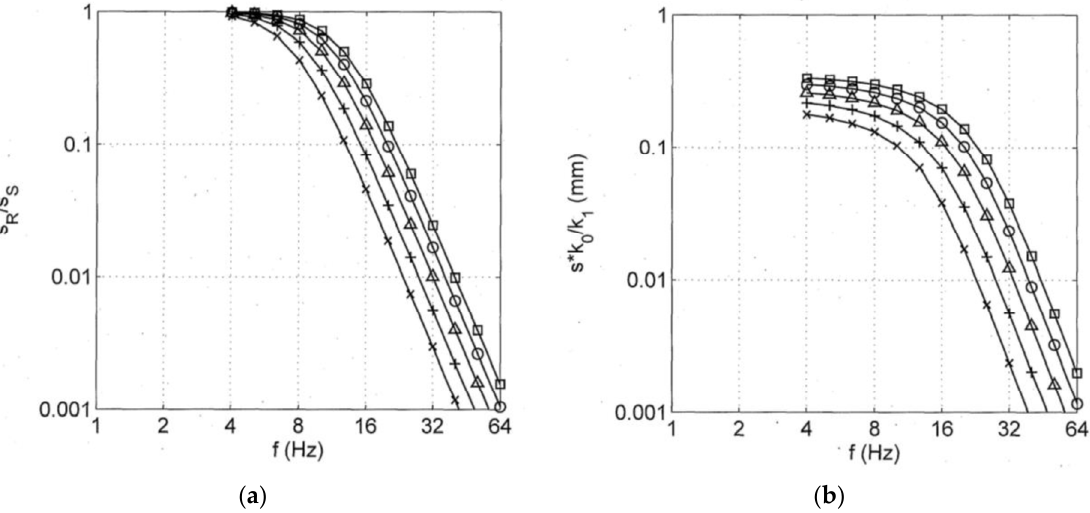
2000, and (cid:3) 3000 kg, — 1500 kg with (cid:35) 80, (cid:35)